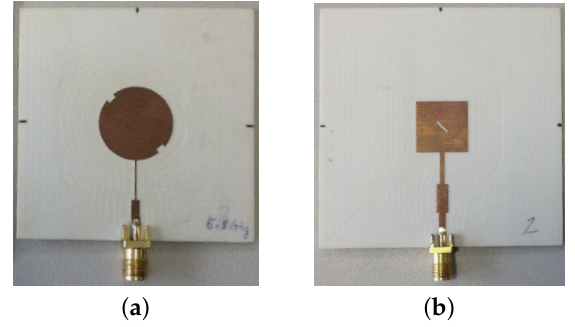
Figure 10. Left-hand circularly polarized (LHCP) antennas made using conventional substrate for 5.8 GHz: ( a ) circular patch antenna [29] and ( b ) squared patch antenna.